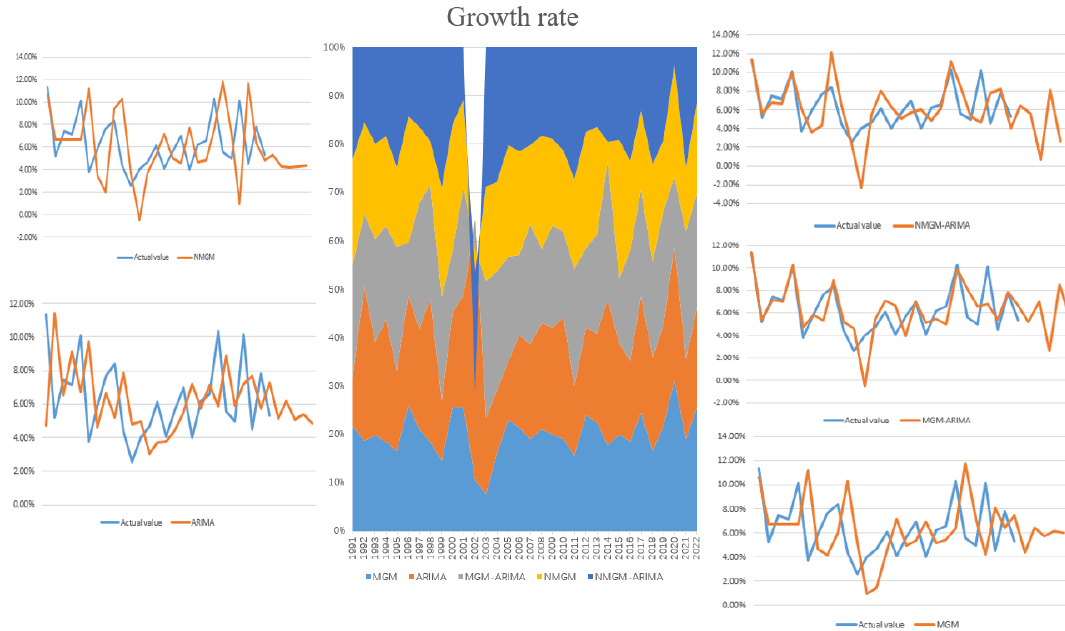
Figure 24. The growth rate of five models,1990–2022. (GWh) .